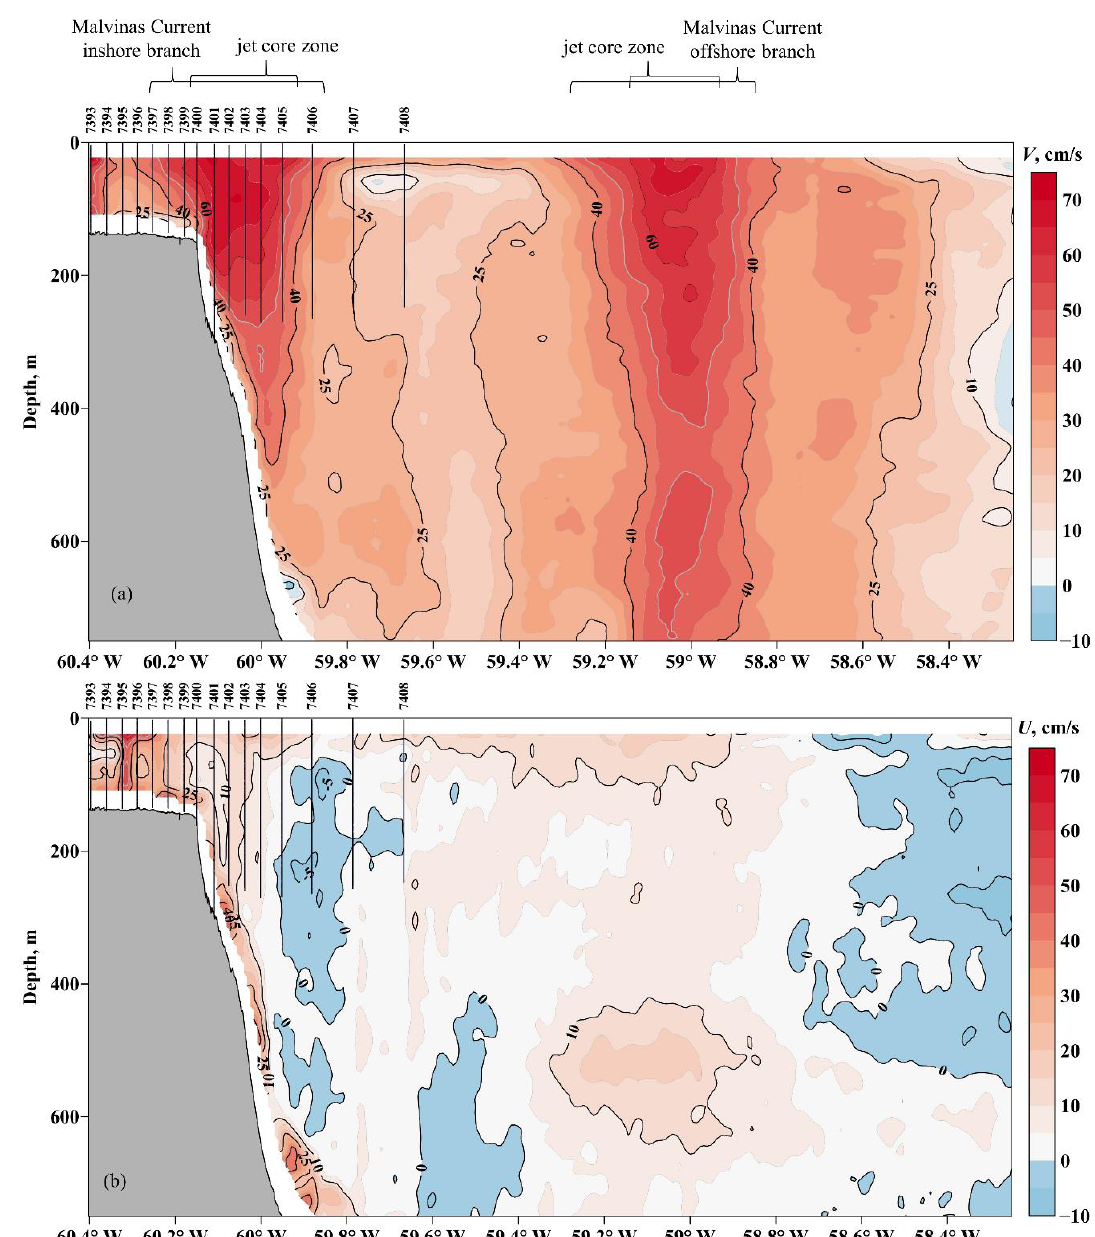
Figure 2. Meridional ( a ) and zonal ( b ) components of SADCP velocity measurements along the section of the study site.